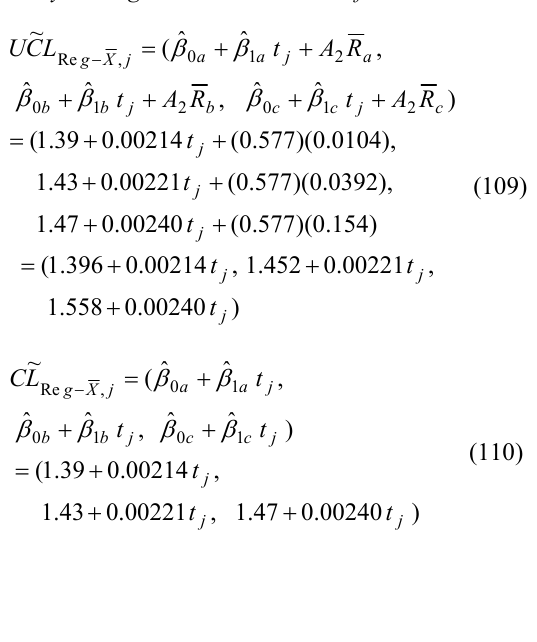
Table 2. Fuzzy triangular number (a,b,c) representation of 25 samples.